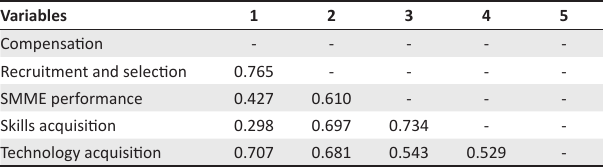
TABLE 2: Heterotrait-monotrait ratios of construct correlations.